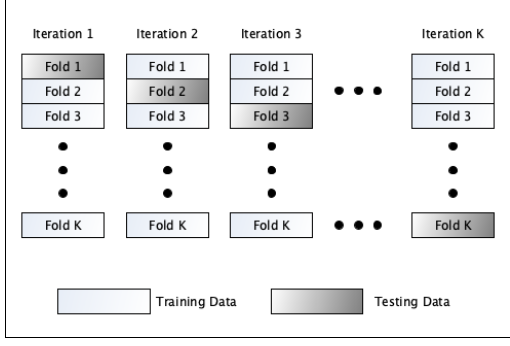
Fig. 3 K-folds cross-validation